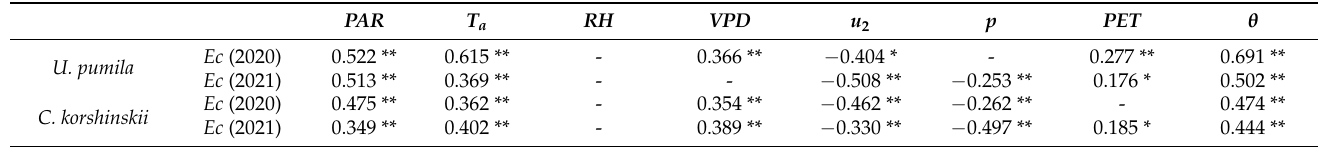
Figure 4. Variations in daily canopy transpiration of per ground area ( E c , a , c ), and monthly tran- spiration ( b , d ) for U. pumila and C. korshinskii . Table 2. Correlation coefficients between canopy transpiration ( E c ) and environmental factors for U. pumila and C. korshinskii in 2020 and